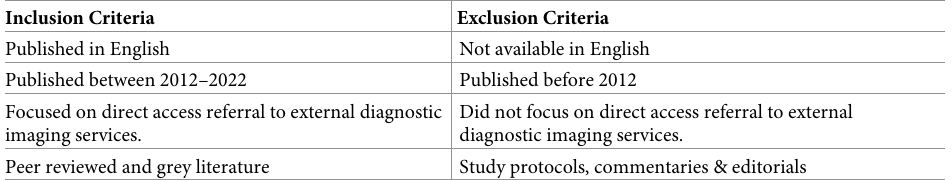
Table 2. Study inclusion and exclusion criteria.